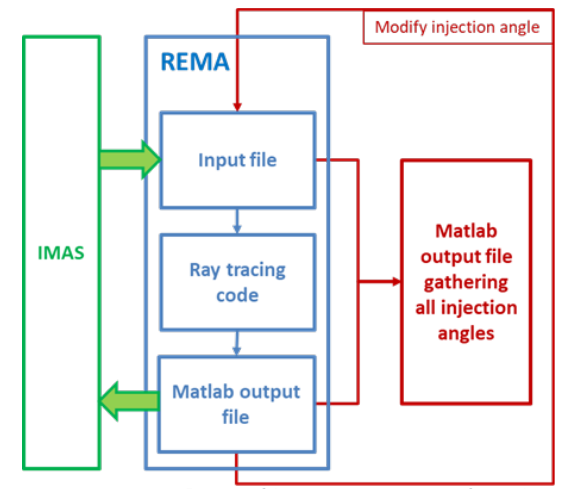
Figure 1: General view of the improvements performed on the REMA code.